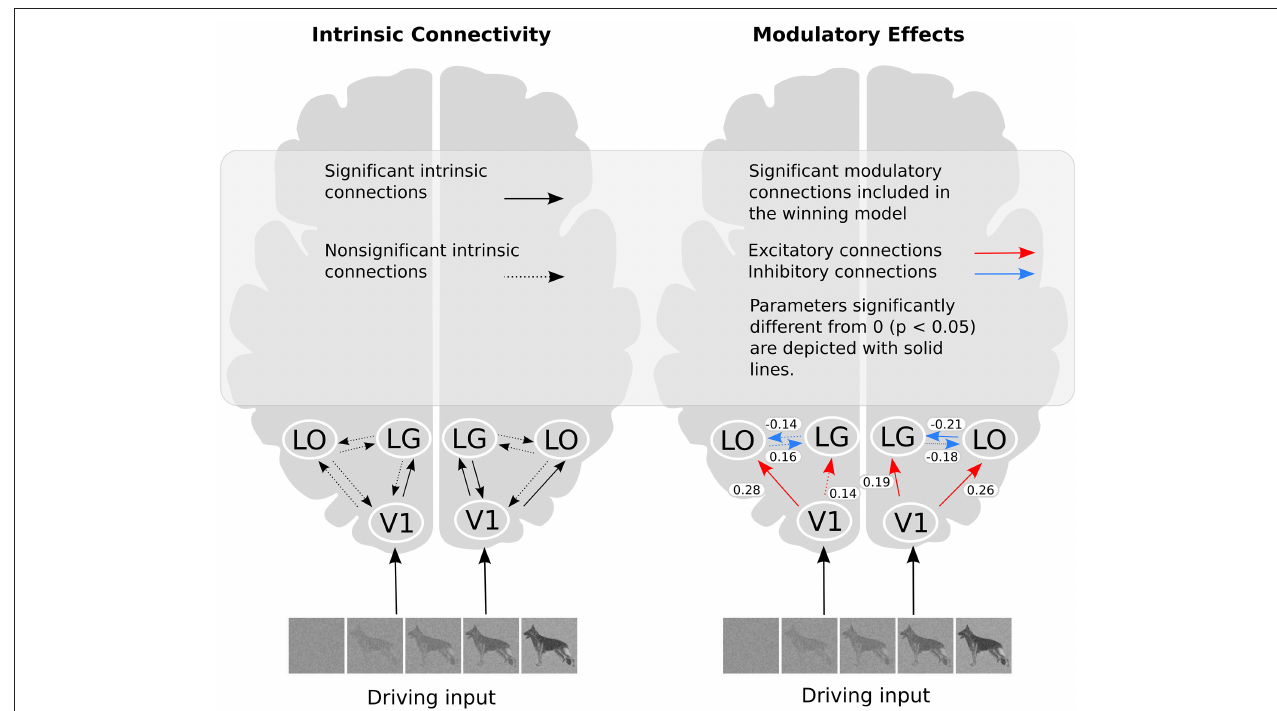
FIGURE 5 | The winning model and the modulatory effect of recognition. In the right part of the figure, the values shown refer to the average parameter estimates.